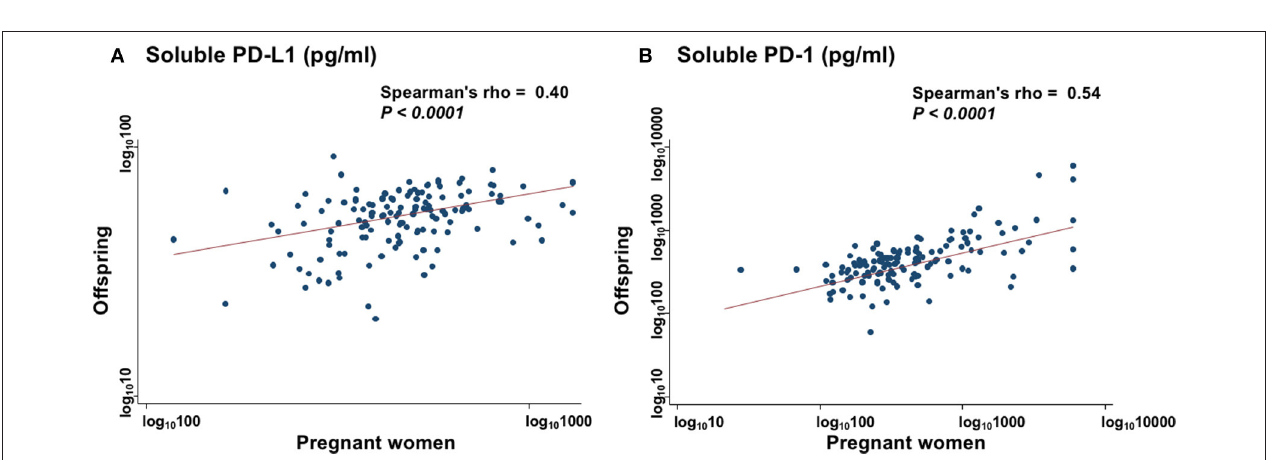
FIGURE 2 | Collinearity levels of sPD-L1 (A) and sPD-1 (B) in serum between PW and matched offspring. Spearman’s rank correlation with linear regression was used to quantify the strength of association; sPD-L1 values were transformed by common logarithm (log 10 ) prior to analysis.